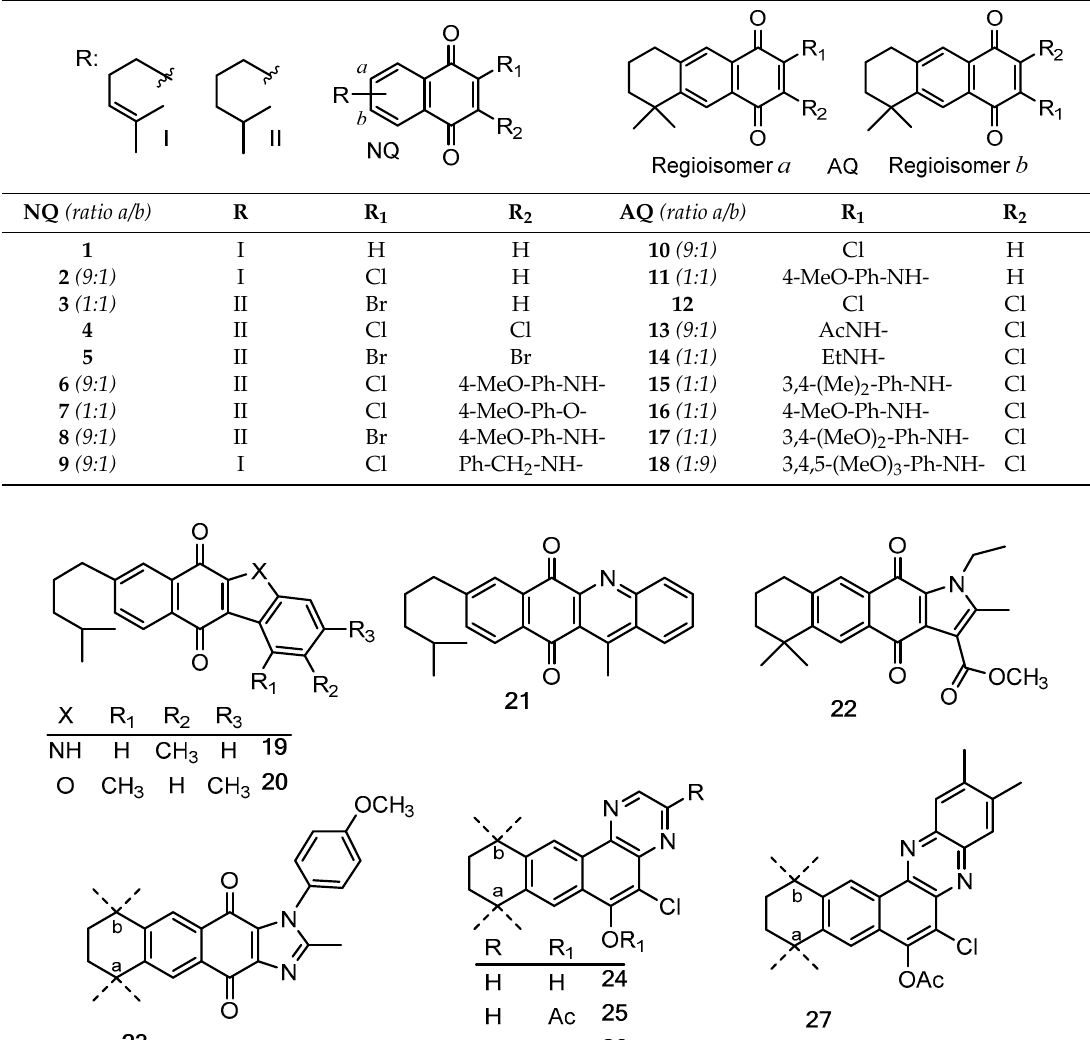
Table 1. Structures of the terpenyl-1,4-naphthoquinone (NQ) and 1,4-anthraquinone (AQ) derivatives tested.